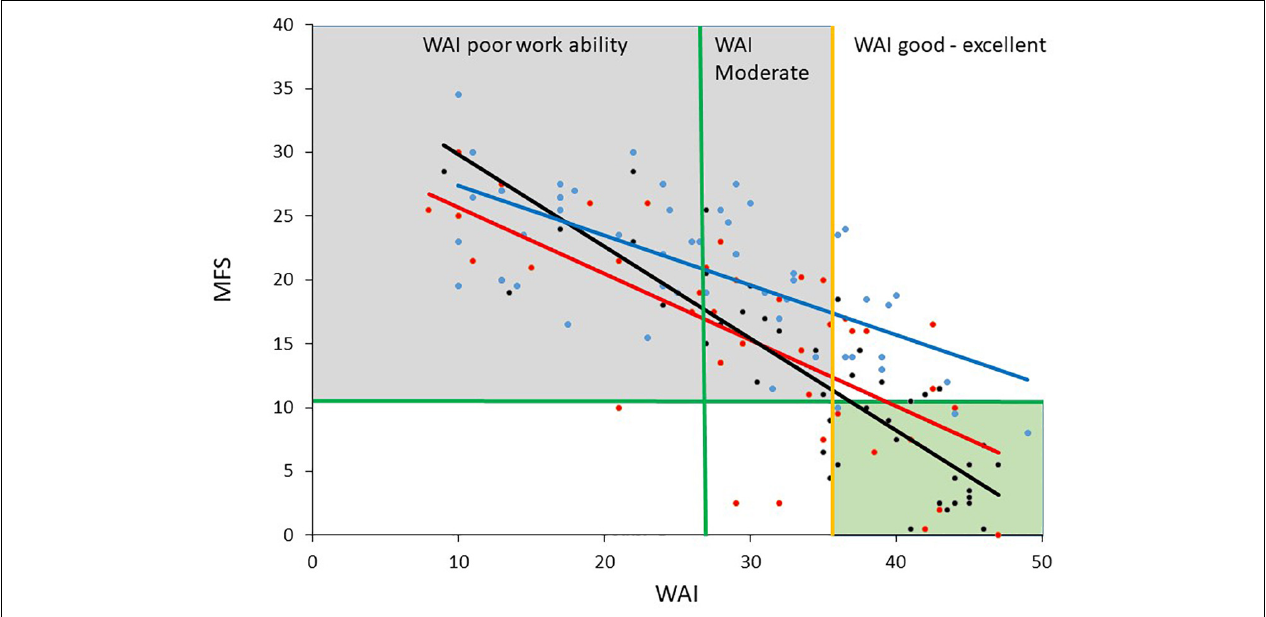
FIGURE 1 | The figure shows the diagnostic groups ABI (acquired brain injury, red), HYT (hypothyroidism black) and BO (burn-out syndrome, blue), and the relationship between WAI (Work Ability Index) and MFS (Mental Fatigue Scale). The gray square indicates poor and moderate work ability according to WAI, together with mental fatigue above cutoff. The green square indicates good work ability and no significant mental